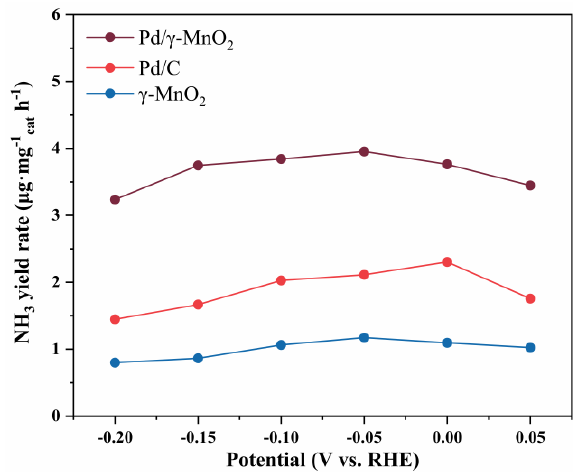
/ γ -MnO / C, and γ -MnO 2 , Pd 2 catalysts at various potentials.